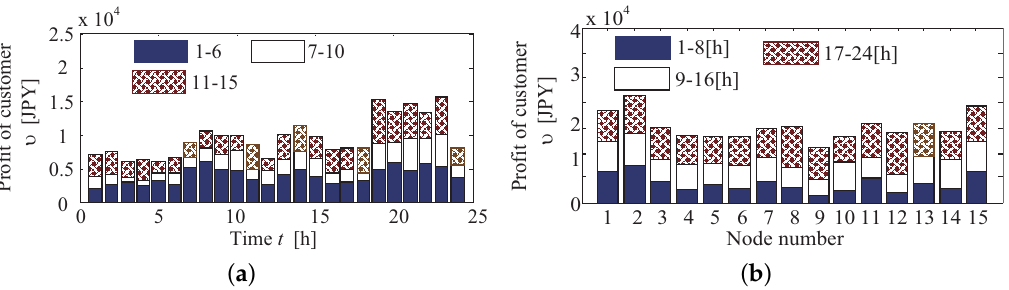
Figure 14. Profit of the customer from reactive power incentive (Case 4). ( a ) Hourly profits of each node and ( b ) end-of-day profit for customers at each